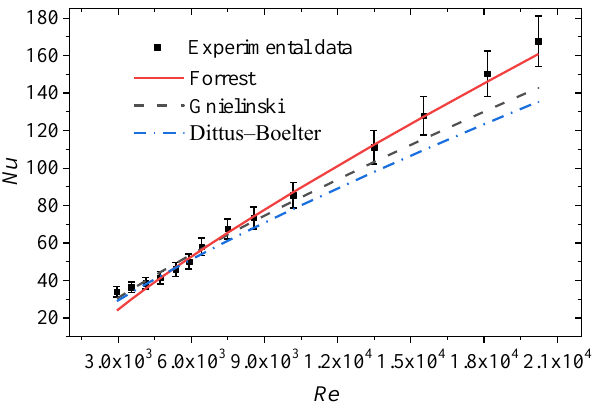
Figure 9. Heat transfer correlation with experimental data under constant Re .